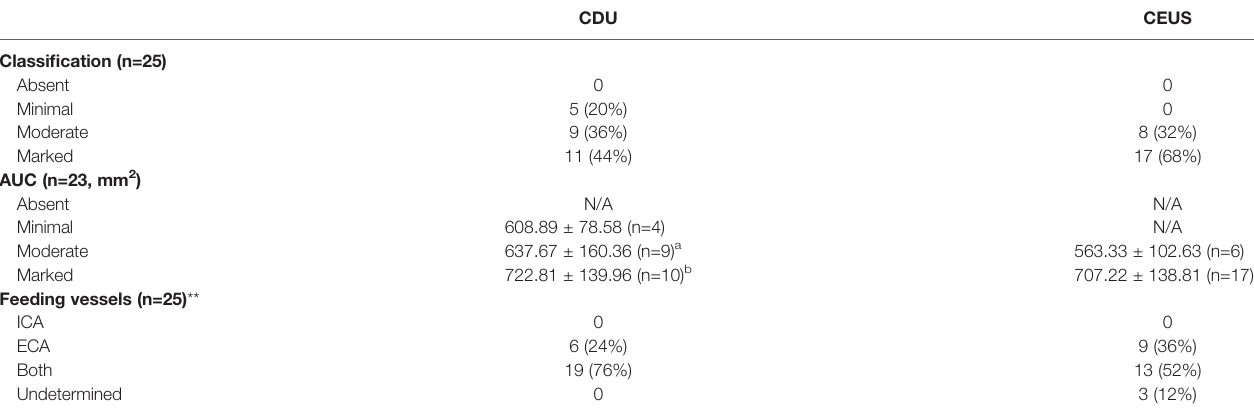
TABLE 3 | Vascularity feature of CBTs.